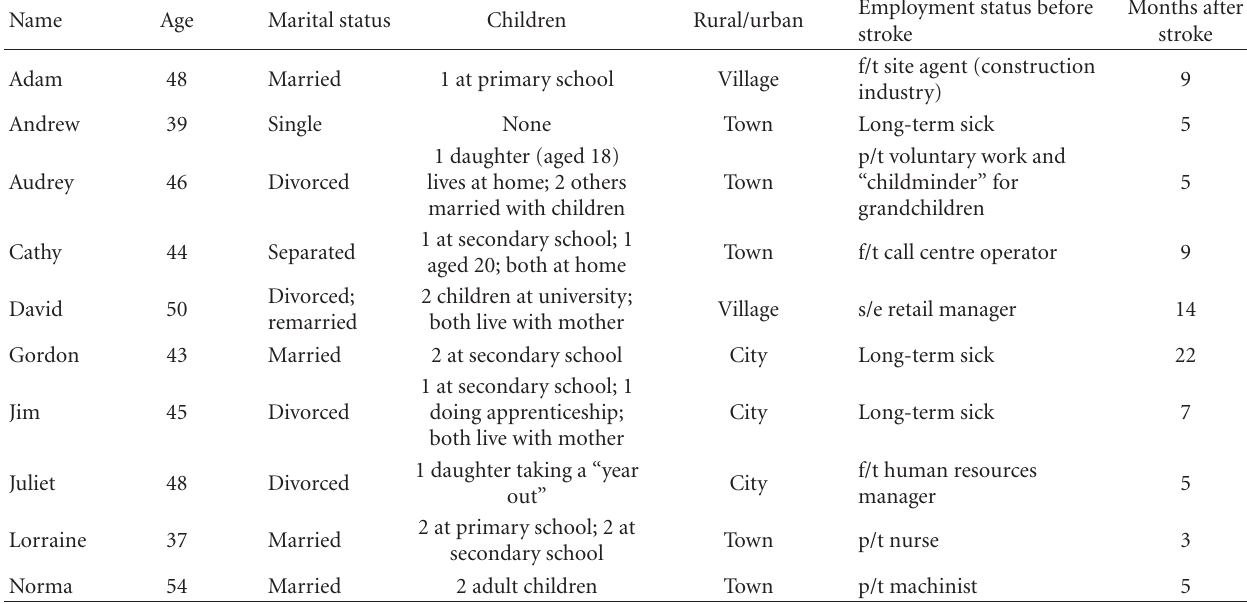
Table 1: Participants’ demographic details. Key: p/t: part-time; f/t: full-time; s/e: